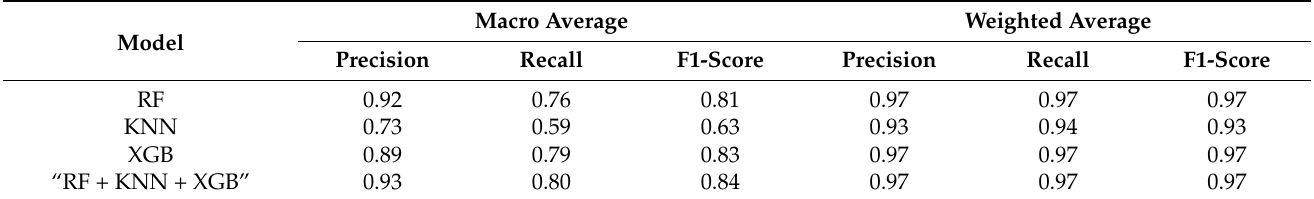
Table 4. Results of the fault diagnosis models on the test set. Macro Average Weighted Model